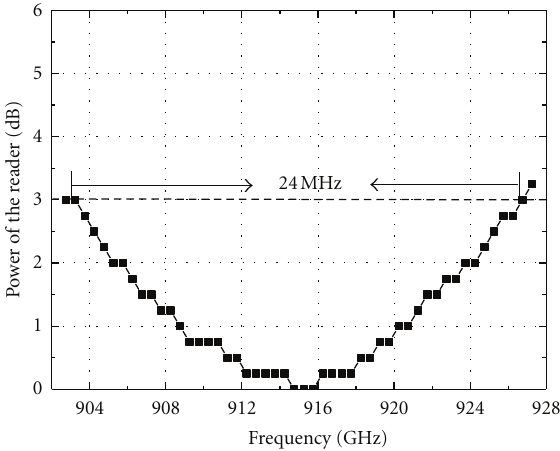
Figure 9: Power bandwidth of the tag antenna.